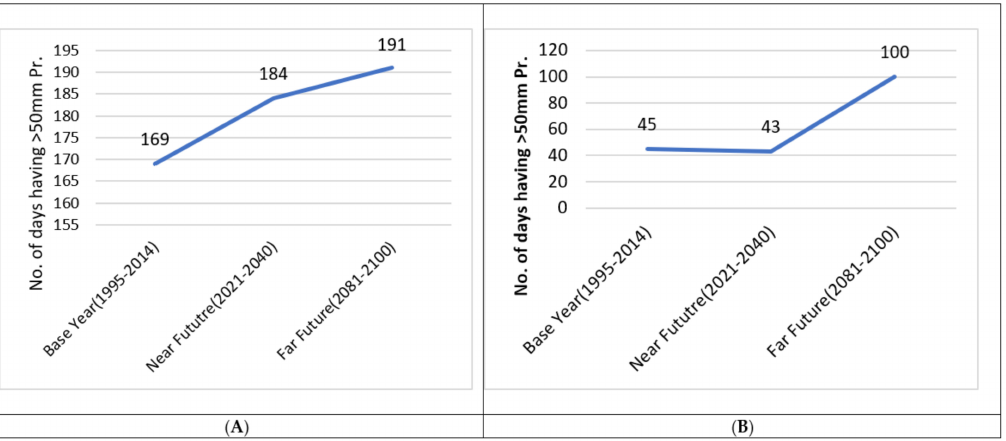
Figure 4. Number of days having greater than 50 mm precipitation ( A ) from the BCC-CSM2-MR model and ( B ) from the MRI-ESM2-0 model.